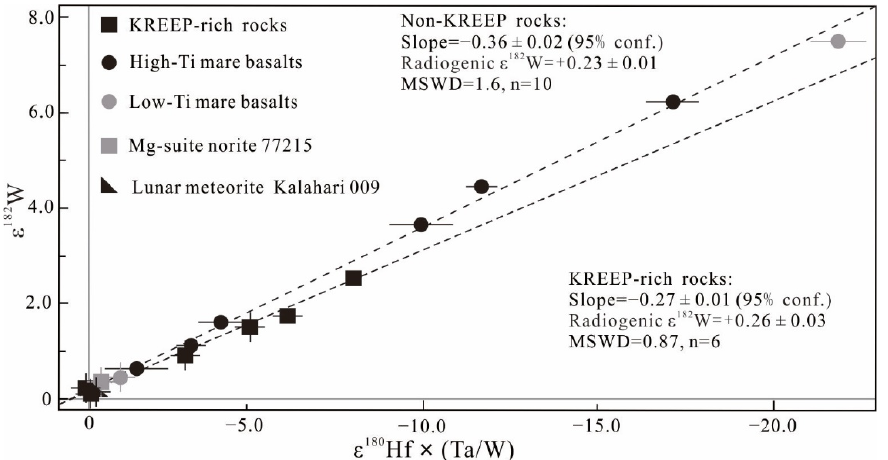
Figure 3. ε 182 W vs. ε 180 Hf × (Ta/W) diagram for lunar rocks (modified after [15]). The intercept of the dashed line represents the radiogenic ε 182 W of the rocks. The slope was considered to reflect different neutron energy spectra of rocks with distinct chemistry compositions ( − 0.27 for KREEP-rich rocks and − 0.36 for non ‐ KREEP rocks).